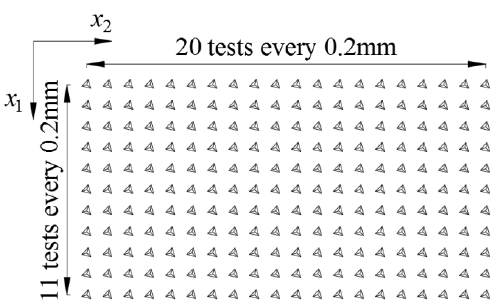
Figure 8. Applied nanoindentation grid.